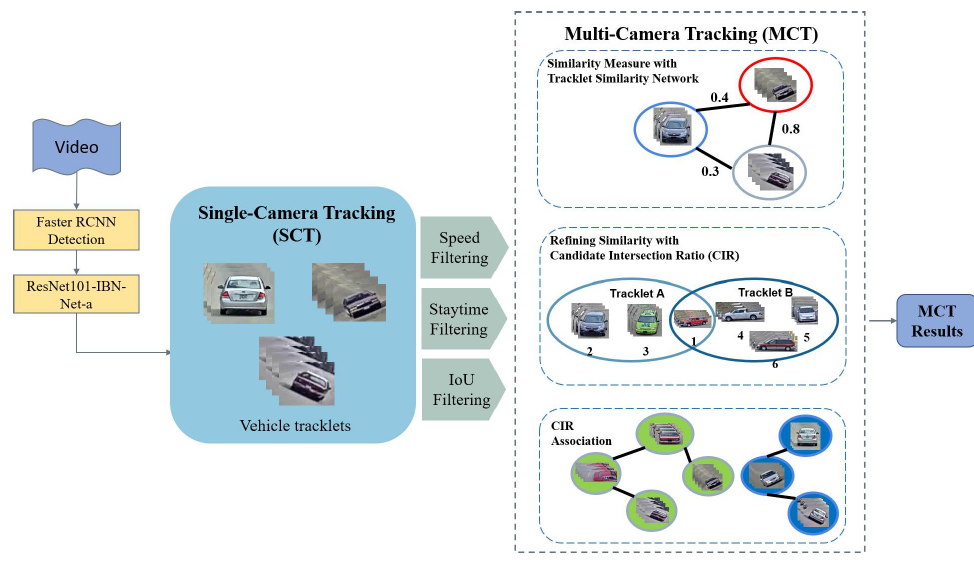
Figure 2. Multi-target multi-camera tracking